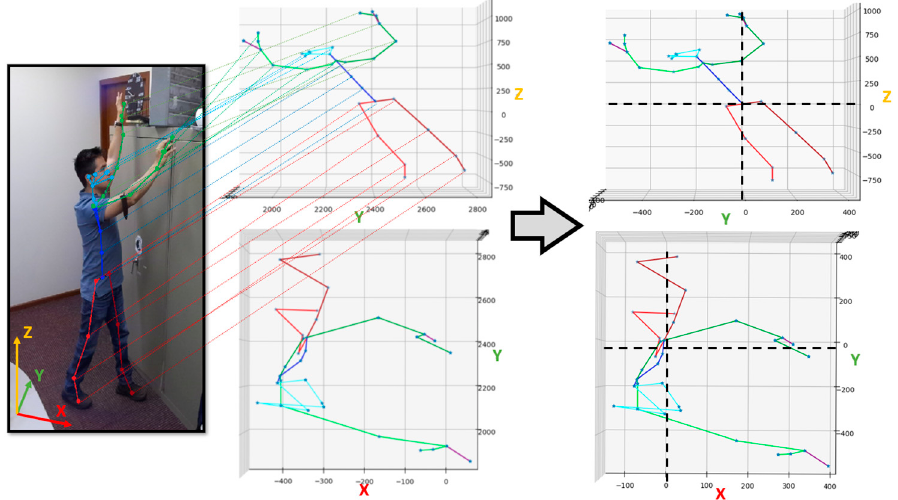
Figure 5. Step 2: Joints translation to the origin of the coordinate plane (0, 0, 0) on the pelvis joint.